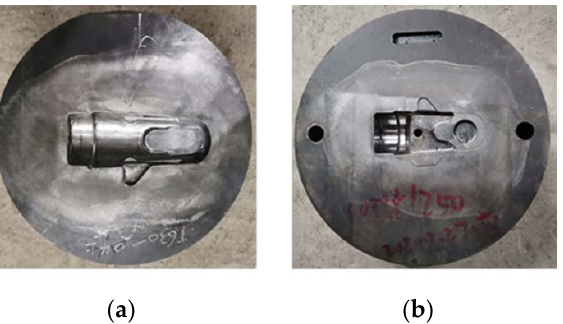
Figure 6. Experimental tools for cold orbital forming of the aluminum alloy component with complex shape : ( a ) Rocking punch, ( b ) Lower die.